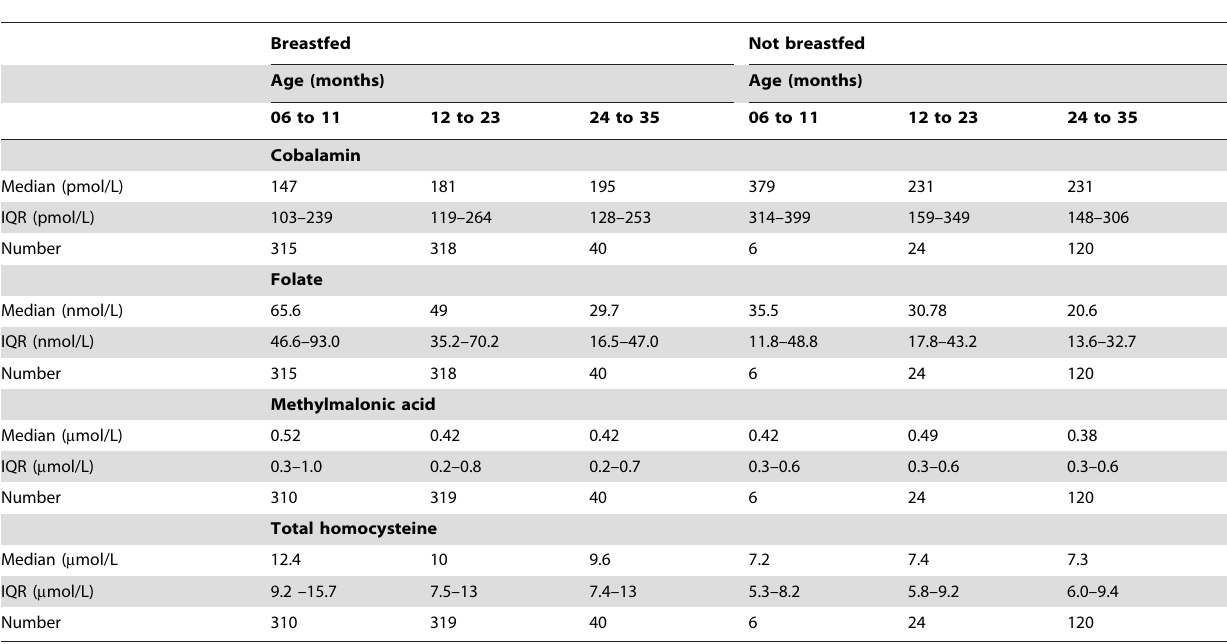
Table 3. Plasma cobalamin, folate, methylmalonic acid and total homocysteine concentrations in different age groups according to breastfeeding status of the study children in Bhaktapur,